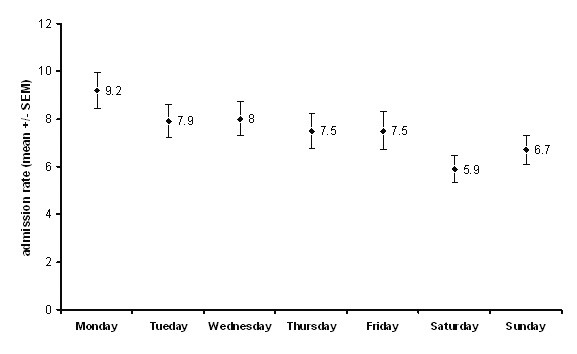
Admissions per day of the week. Results are expressed as mean ± standard error of mean.